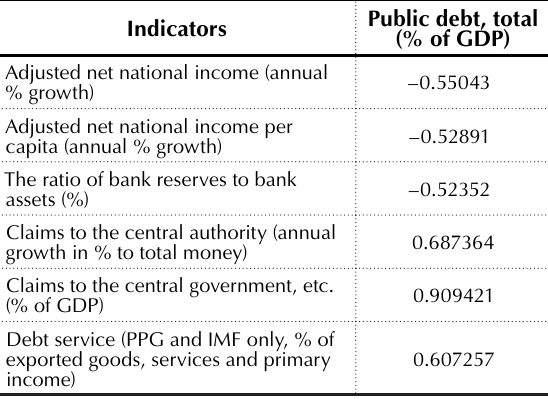
Table 3. Correlation coefficients of the impact